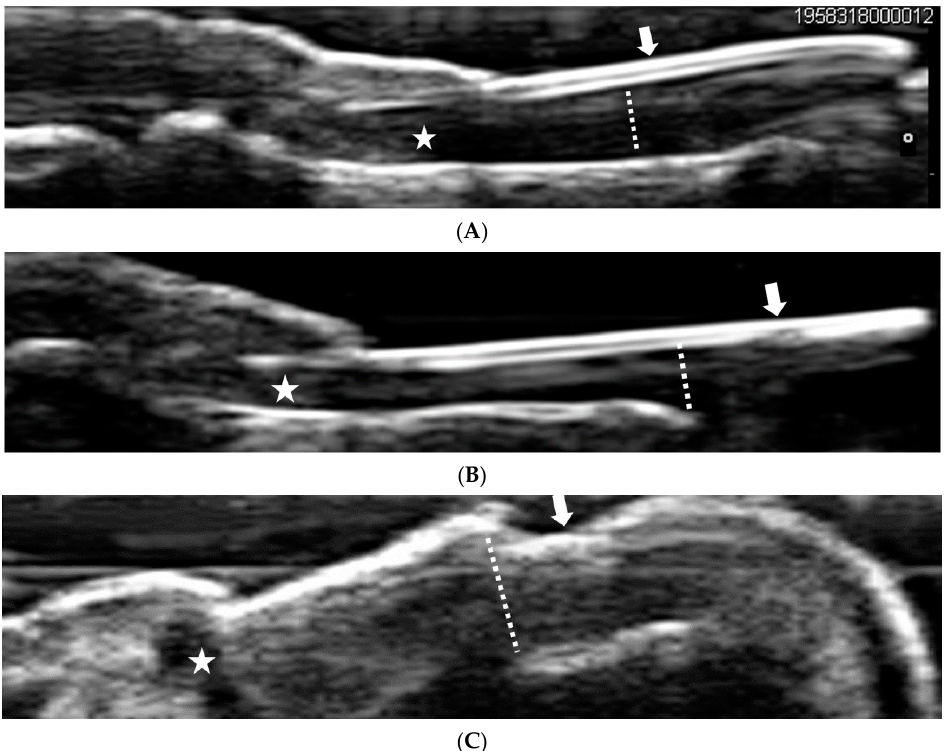
Figure 1. Comparison health control with nail psoriasis. ( A ). Grayscale ultrasonogaphy of the fingernail in a healthy control. Arrow: trilamellar and convex structure of nail plate with two hyperechoic lines, ventral and dorsal, separated by a hypoechoic line. Dashed line: the diameter of the nail bed is thinner in the distal part than the proximal. Asterisk: nail matrix present. ( B ). Grayscale ultrasonography of the fingernail in mild psoriatic nail disease. Arrow: interruption of hyperechoic line and loss of convex structure of nail plate (Wortsmann type II). Dashed line: loss of thinner distal part of nail bed. Asterisk: nail matrix present. ( C ). Grayscale ultrasonography of the fingernail in severe psoriatic nail disease. Arrow: a single and wavy hyperechoic layer losing its normal trilamillar appearance (Wortsmann type IV). Dashed line: thickening of nail bed. Asterisk: loss of normal nail matrix structure. Table 2. Nail morphometry in ultrasounds.